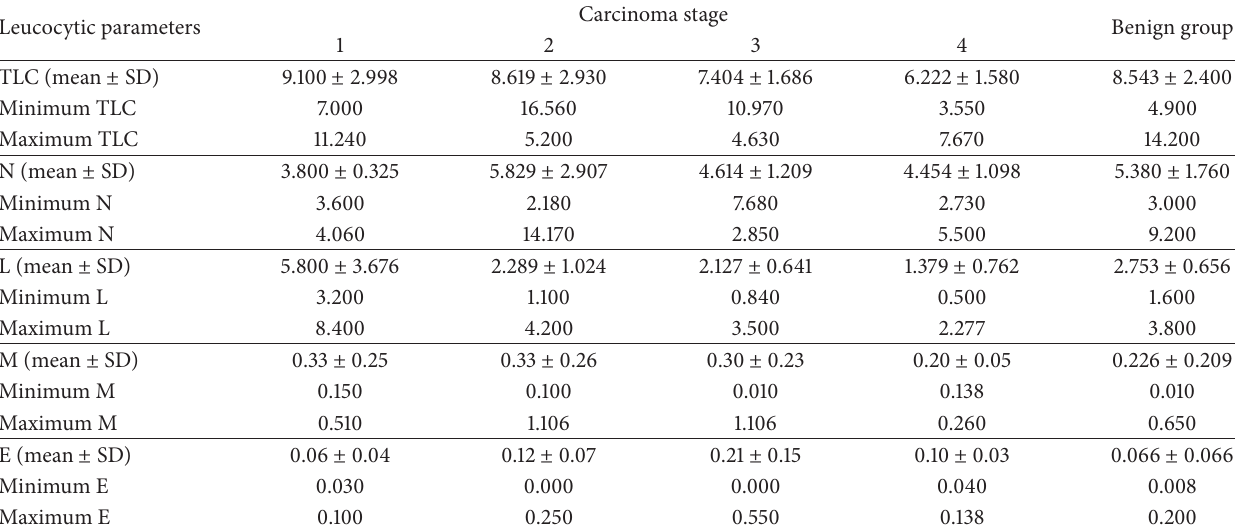
Table 4: Relation of various leucocytic parameters with four stages of carcinoma and benign